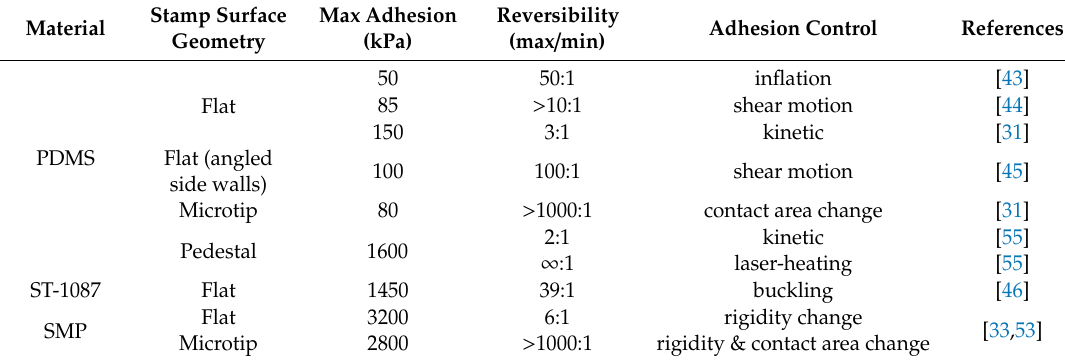
Table 1. Comparison of adhesive strength and reversibility for various stamps available in the literature [33].